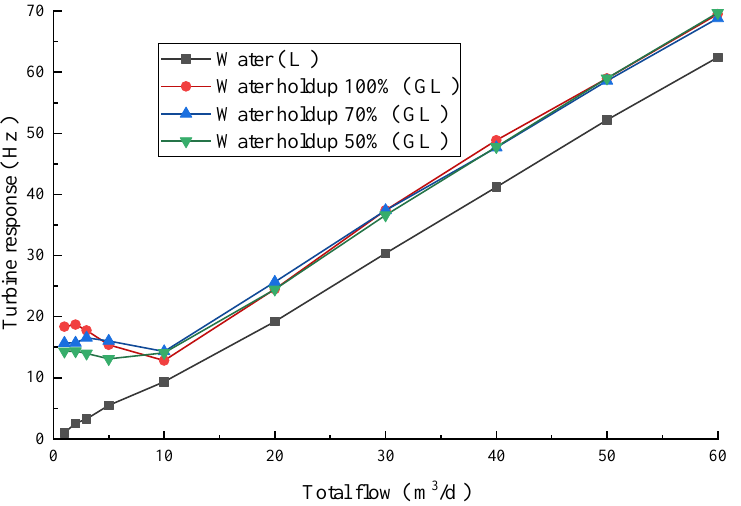
Figure 16. Response curve of the turbine flowmeter with different total liquid flow when gas flow rate is 15 m 3 /d.